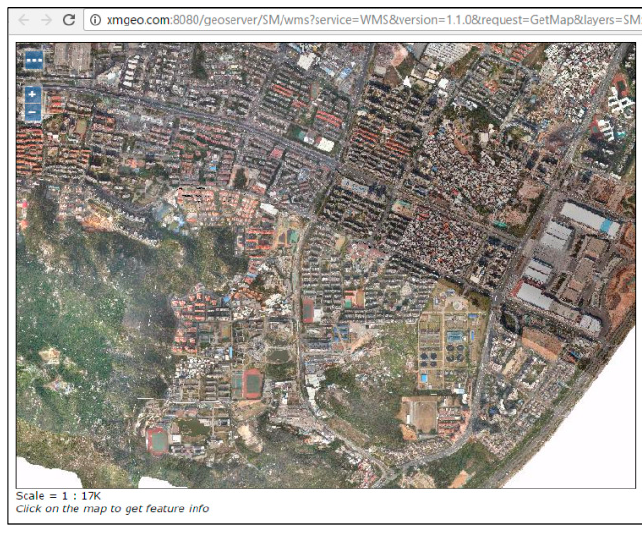
Figure 11. Image release.